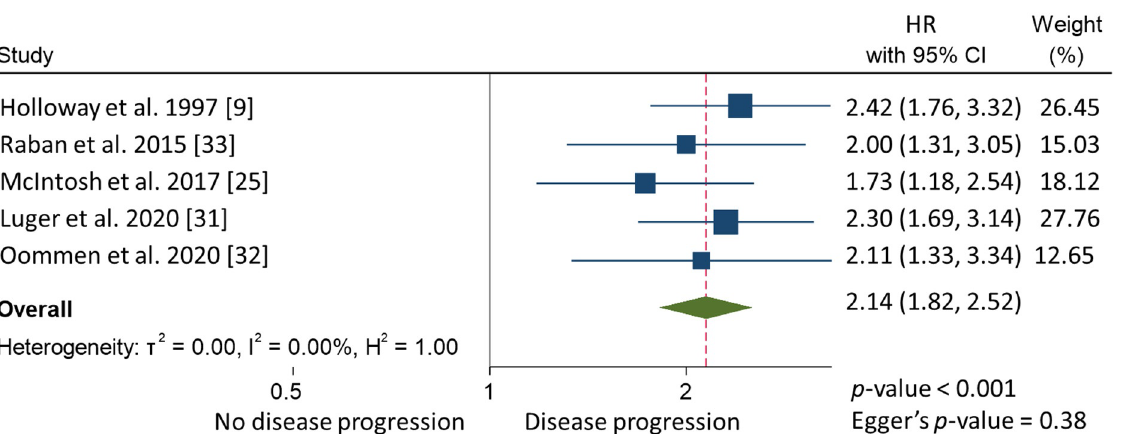
Figure 2. Forest plot displaying hazard ratios for mortality at 5 years after optimal abdominal cytoreduction surgery in patients with CPLN adenopathy relative to those with no adenopathy.